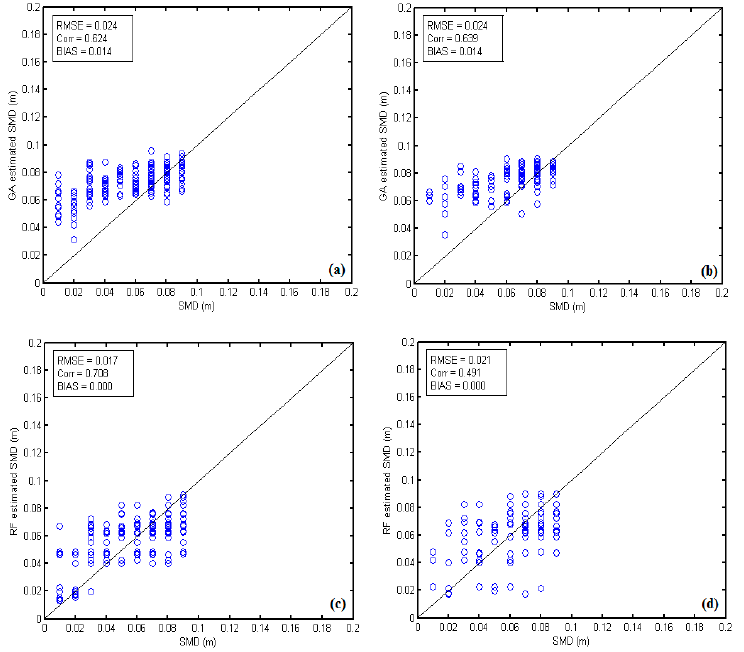
Figure 5. Performances of RFs and the Genetic algorithm during calibration ( a – c ) and validation ( b – d ). ( b – d